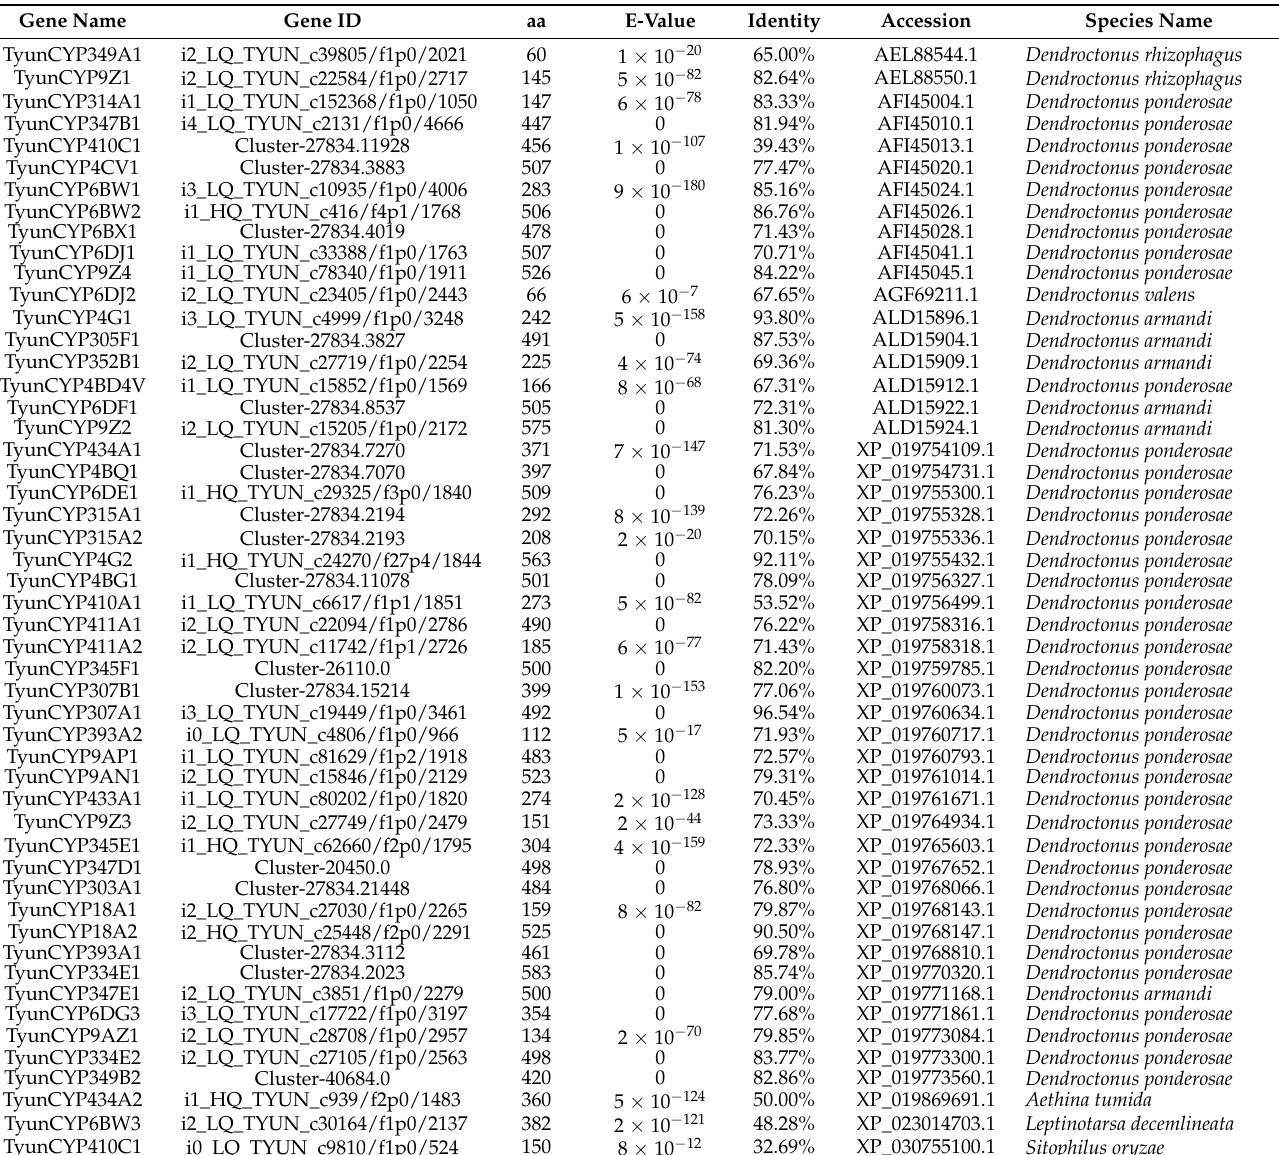
Table 4. Best BLASTX matches of T. yunnanensis